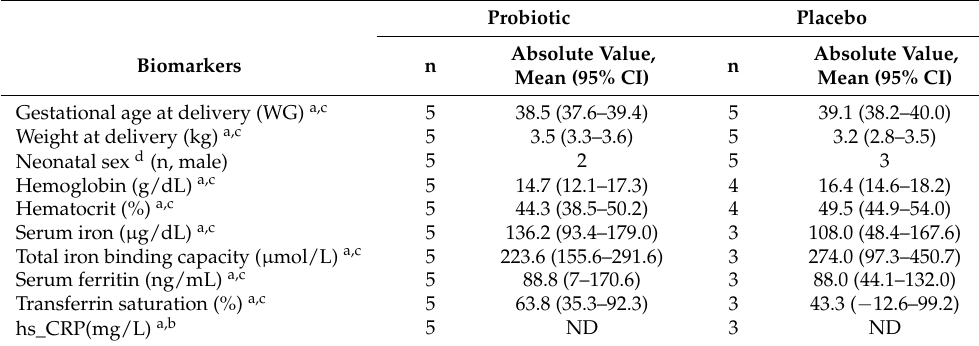
Table 7. Neonatal demographic characteristics and hematological and iron status biomarkers for ≥ 80% adherence by treatment